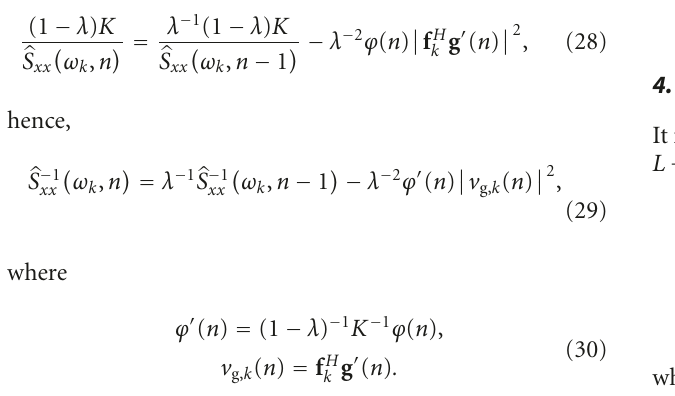
Algorithm 1: A recursive Capon inverse spectral